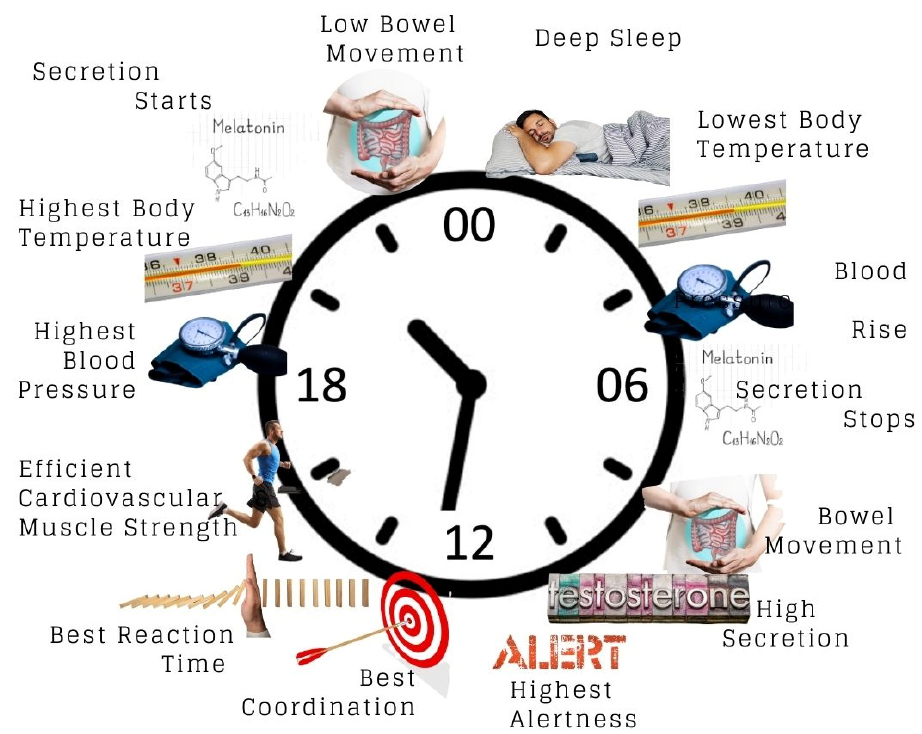
Figure 1. 24 h circadian rhythm and human body response. The clock system in Figure 1 represents 24 h clock time that uses the numbers 00:00 (midnight) to 23:59 to tell the time. A group of nerve cells forming the suprachiasmatic nucleus (SCN) in the anterior hypothalamus play roles in regulating the circadian rhythm. The SCN is set by the circa-